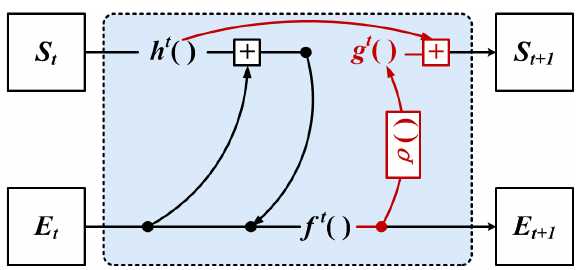
Figure 8. The neighbor feature alignment